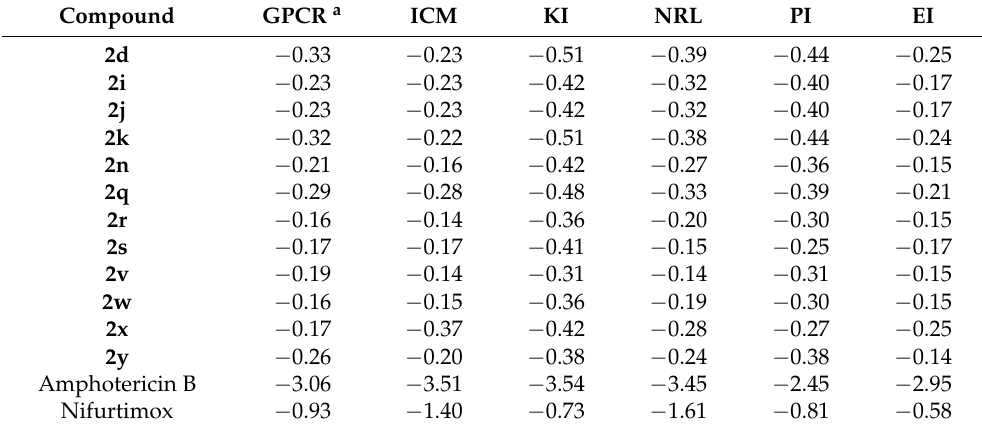
Table 5. Bioactivity scores of the synthesized 4,4 (cid:48) -(arylmethylene)bis(3-methyl-1-phenyl-1 H